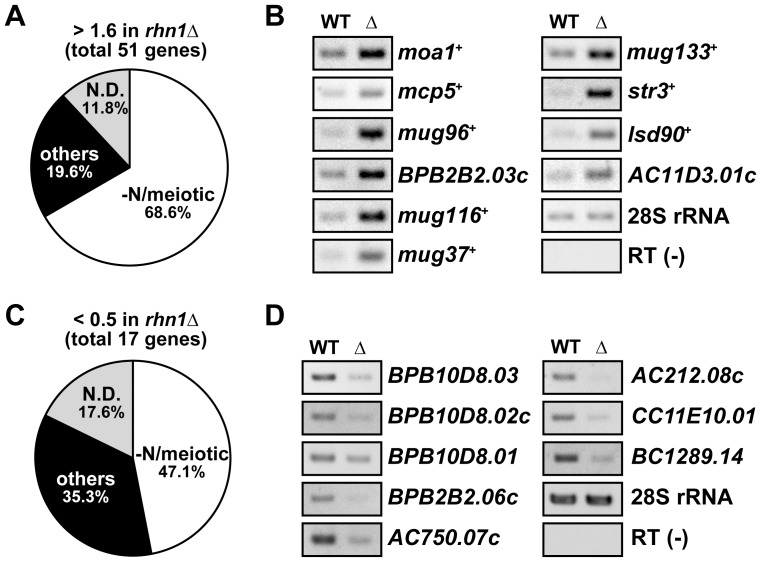
Expression profiling of vegetative rhn1Δ cells.(A) A pie chart of the classification of mRNAs accumulated in vegetatively growing rhn1Δ cells. Expression analyses using a microarray technique demonstrated that 51 genes were upregulated (>1.6-fold) in vegetatively growing rhn1Δ cells, and subsequent analysis revealed that 35 of these 51 genes (68.6%) were previously reported to be genes upregulated in response to nitrogen starvation, pheromone treatment, or during meiosis (-N/meiosis). In addition, 10 genes were non-meiotic genes (others) and 6 genes were not known to be meiosis-related (N.D.). (B) Total RNAs isolated from wild-type (WT) and rhn1Δ (Δ) cells were subjected to RT-PCR analyses to confirm the results of the expression profiling. The 28S rRNA was used as a control. RT (-), no reverse transcription. (C) A pie chart of the classification of mRNAs downregulated (<0.5-fold) in rhn1Δ cells. Total 17 genes were identified and classified into three categories as described in (A). (D) RT-PCR of several mRNAs downregulated in rhn1Δ cells. RT-PCR was done as described in (B).